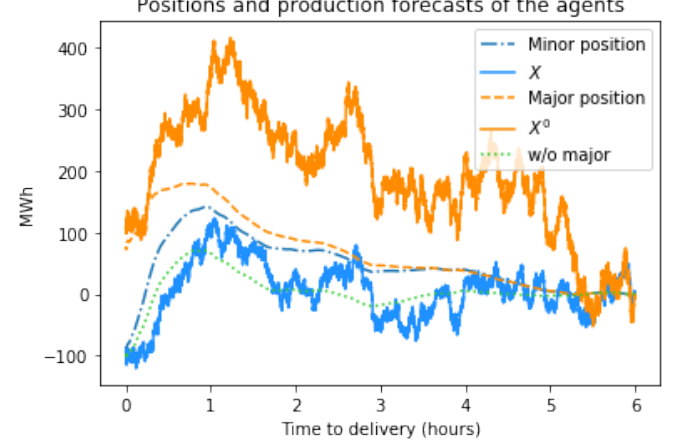
Figure 1. Demand forecasts and agents’ positions in the Stackelberg